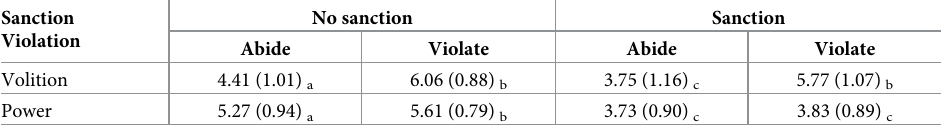
Note. Means within a row with a different subscript differ at p <